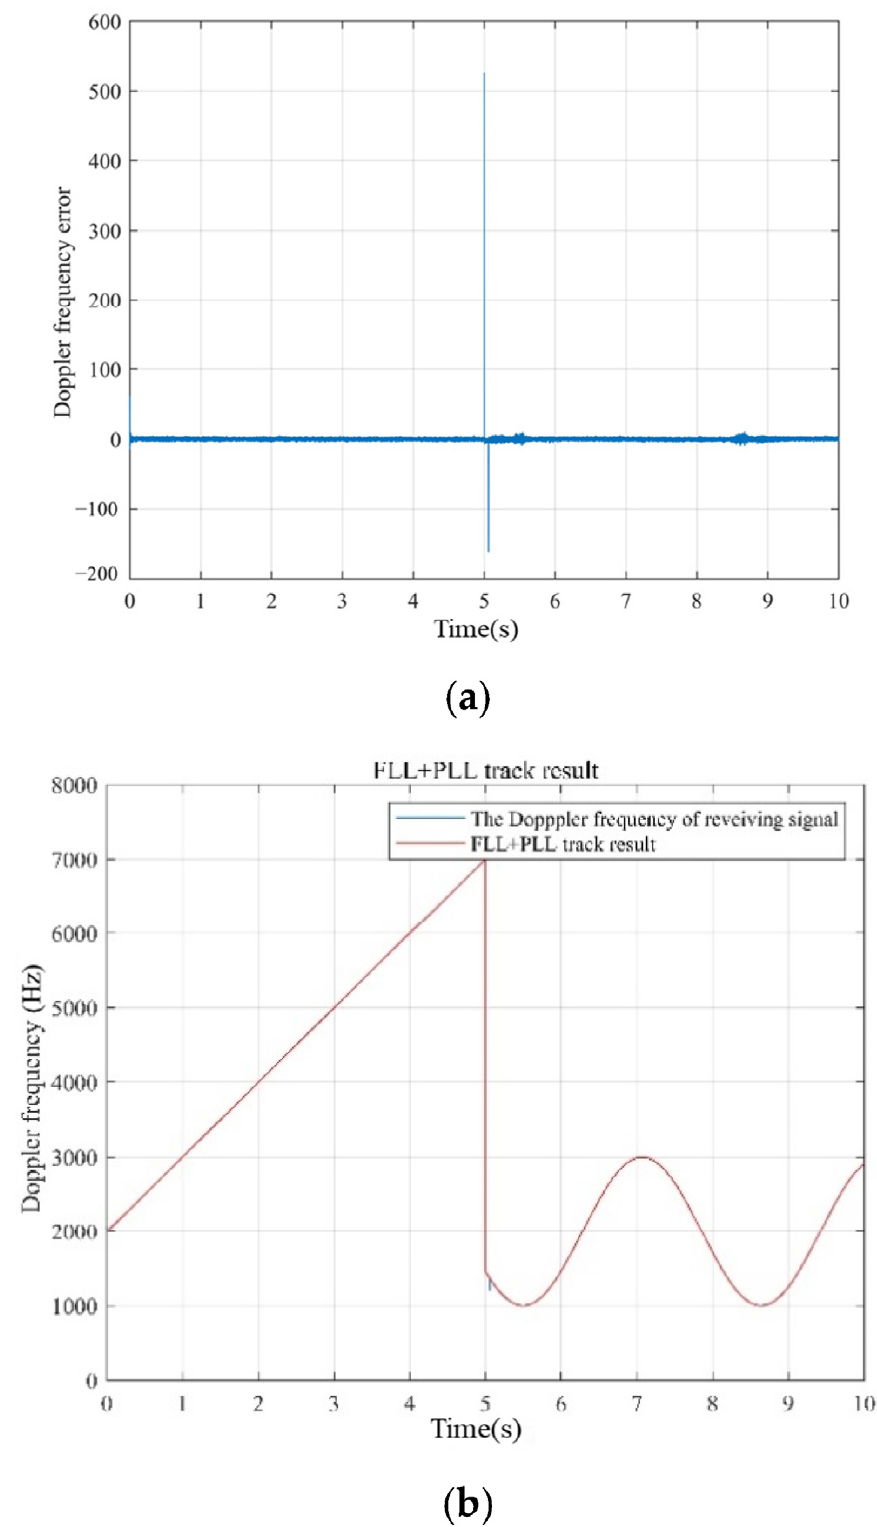
Figure 12. The switching time when α : β = 0.5 : 0.5 and C / N 0 = 65 dB-Hz. ( a ) the Doppler frequency error, and ( b ) the Doppler frequency measurement.